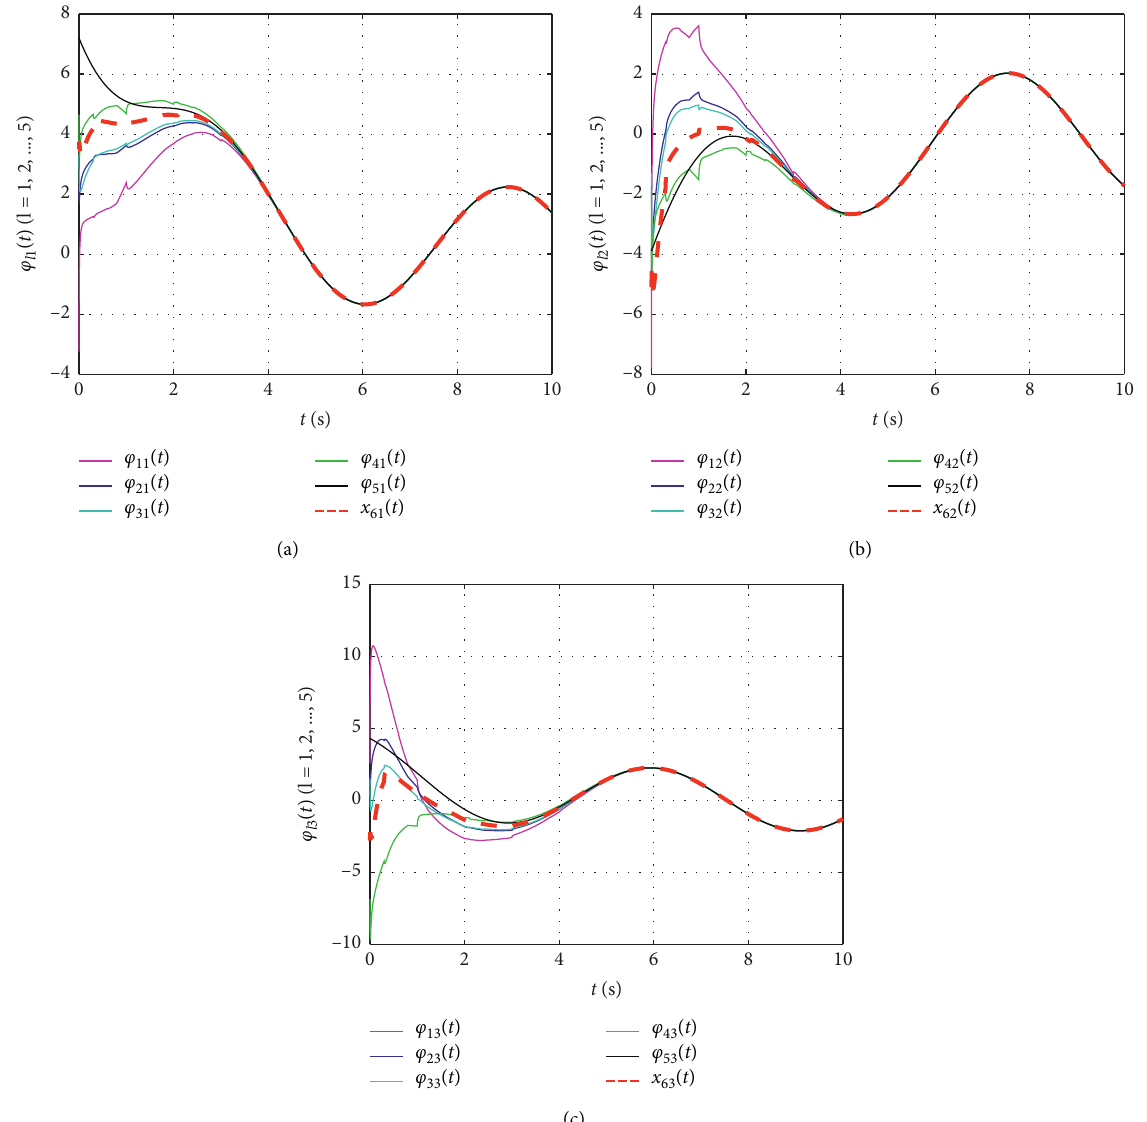
Figure 5: Trajectories of φ